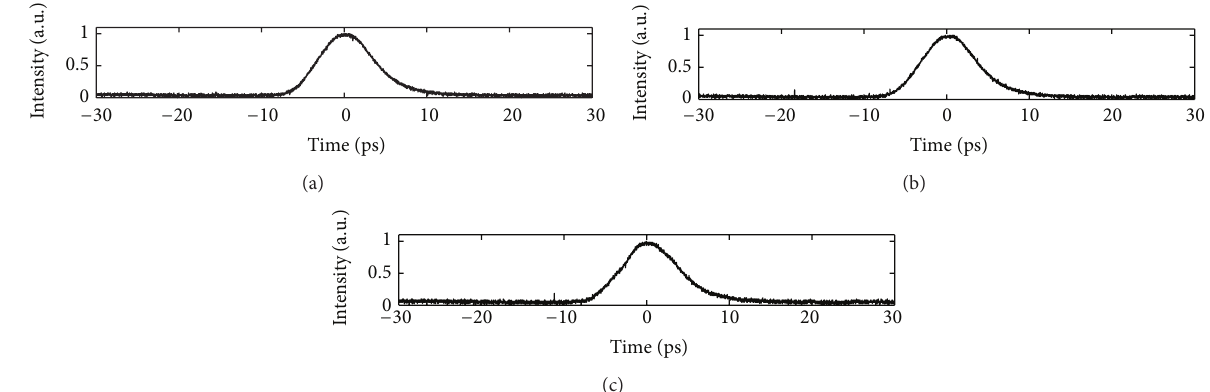
Figure 3: Autocorrelation traces of the (a) fundamental mode-locked, (b) second-harmonic mode-locked, and (c) third-harmonic mode- locked pulses.